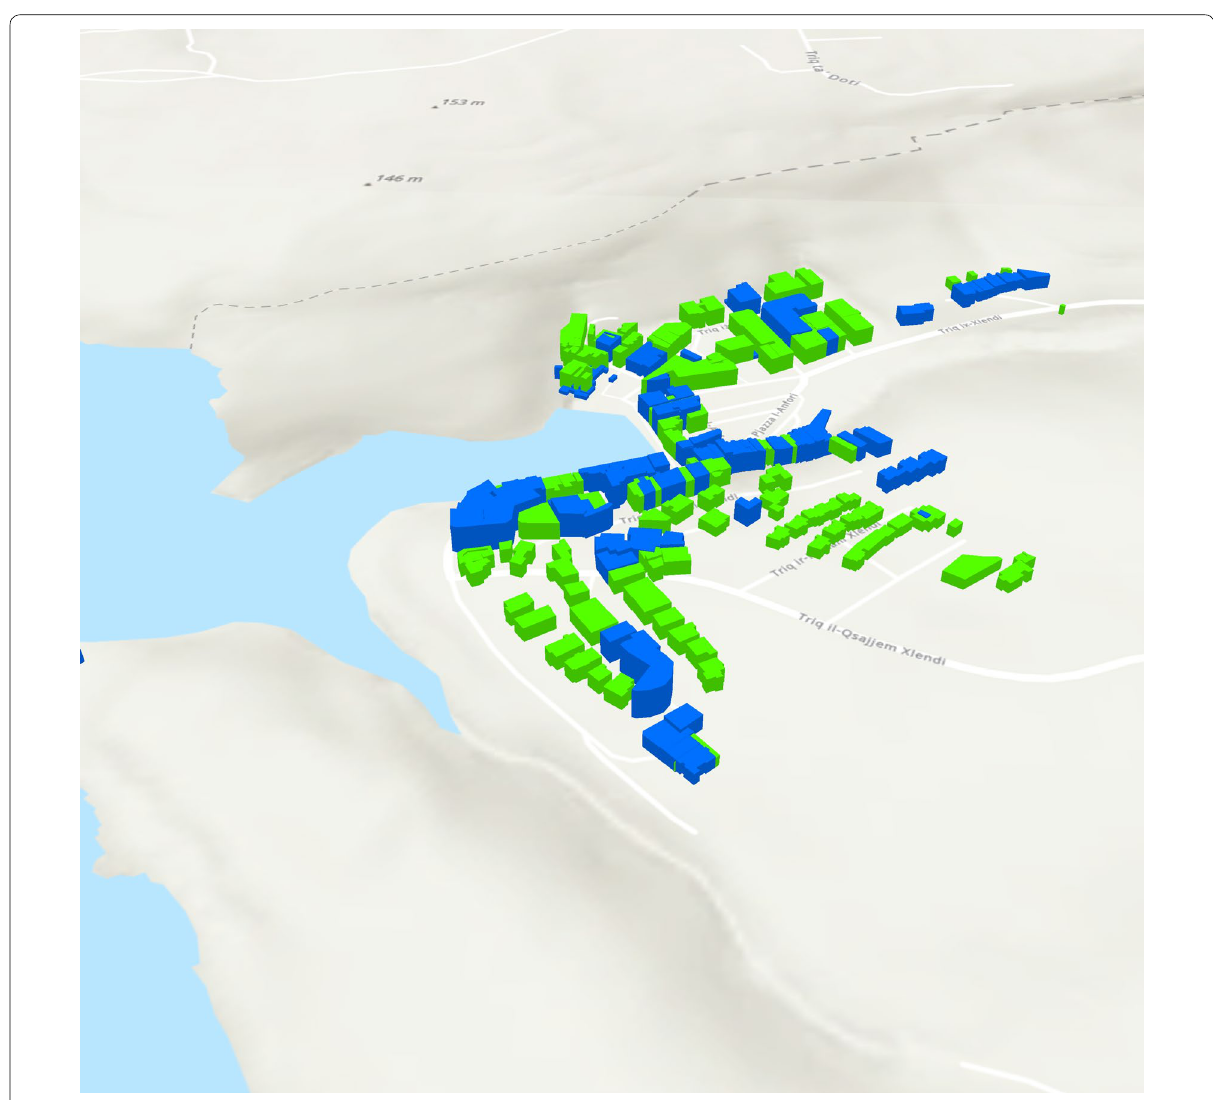
Fig. 4 Xlendi: area inside buffer of 250 m—no infill (blue) and area inside buffer of 250 m—infill